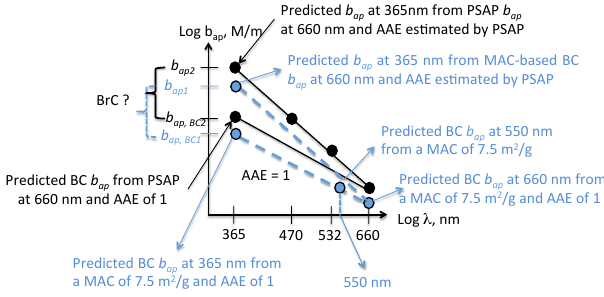
Figure 6. Schematic of how ambient aerosol and BC absorption was extrapolated to lower wavelengths. Square data points represent PSAP measurement, which are used to estimate the ambient aerosol AAE (AAE PSAP ; not shown but is the slope of upper lines), and used to predict ambient aerosol absorption at 365nm ( b ap,PSAP ) . Light absorption by black carbon ( b ap,BC ) is estimated assuming an AAE BC of 1 and extrapolating from the PSAP measurement at 660nm, a size where BrC absorption is minimal, or alternatively assuming a BC MAC of 7.5m 2 g − 1 at 550nm and extrapolating to 365nm with an AAE BC of